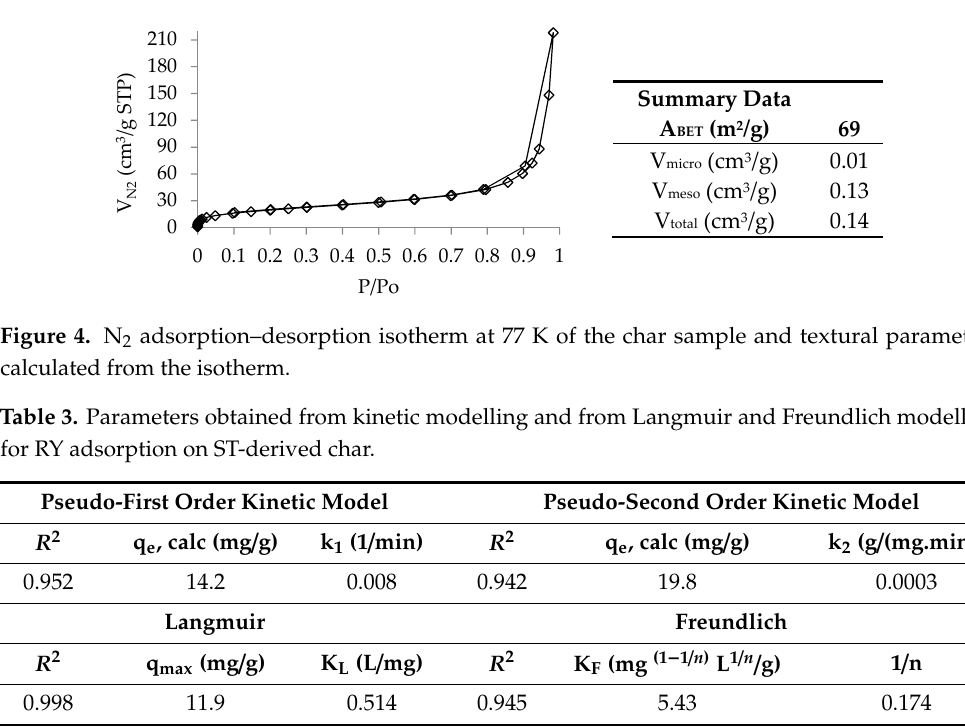
Figure 2. The TGA curves for both spent tire (ST) rubber and char samples.